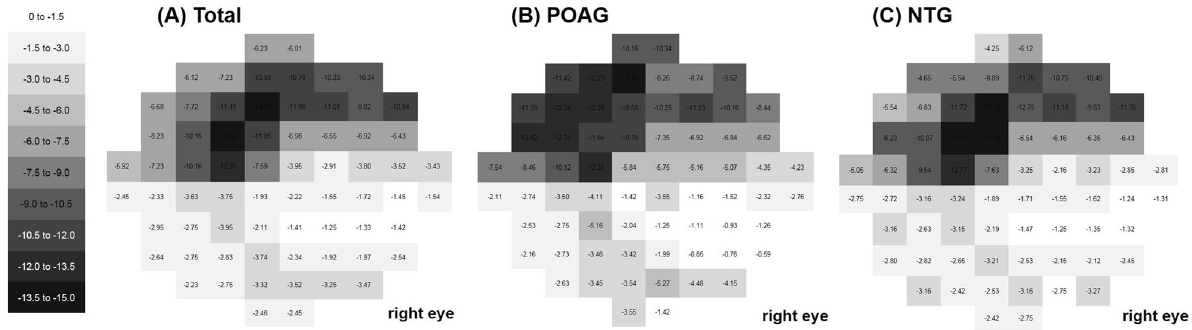
Figure 2. Cross-sectional analysis of the total 10-2 visual tests (VF) during the whole follow-up period. For cross-sectional analysis to show the location and pattern of the paracentral scotoma, numerical values of the total 10-2 VF tests during the whole follow-up period were averaged for each VF test point using the total deviation map, generating one average map for each subgroup. A linear grayscale was generated and applied to all maps. ( A ) Scotoma was located in the superior region in an arcuate pattern that was deep in the 4°–6° region above the region of fixation. ( B ) In the primary open-angle glaucoma group, this arcuate pattern was more broadly located in the 4°–10° region above the region of fixation. ( C ) However, the scotomas were more closely located around the region of fixation in the 0°–4° region in the normal-tension glaucoma